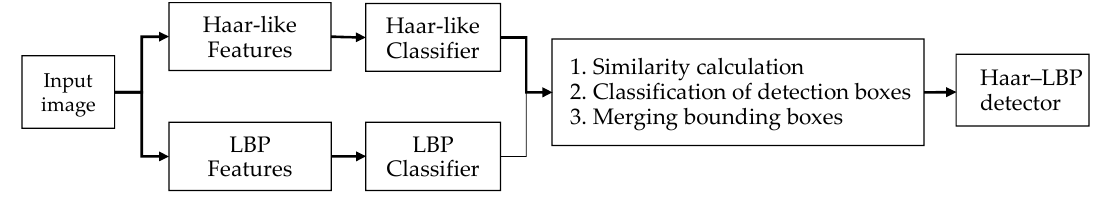
Figure 8. The framework of the Haar–LBP detector.